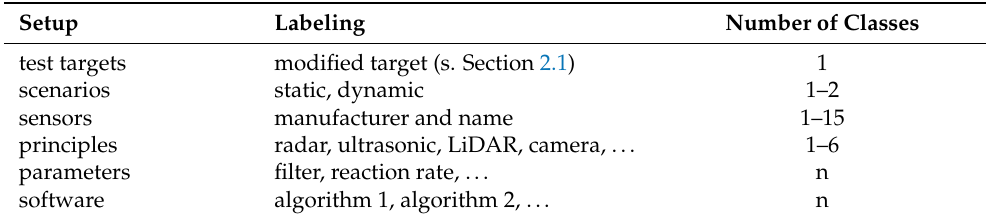
Table 1. The different setups of the application of the novel test method “REDA” are presented in this table.